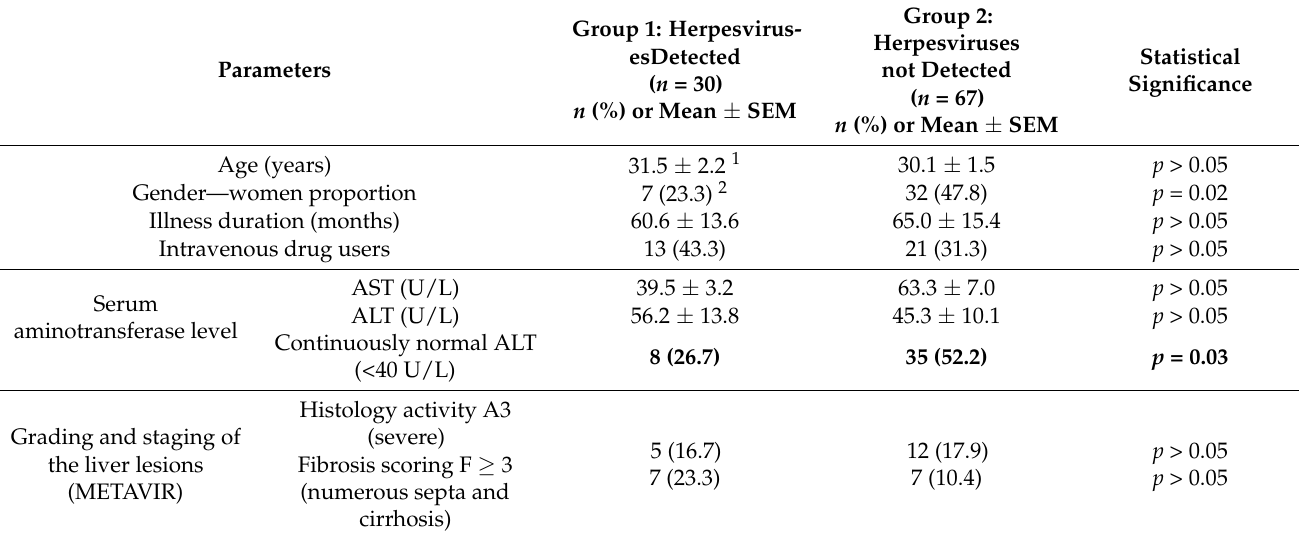
Table 3. Comparison of the demographic, histological, and serologic characteristics of patients with chronic hepatitis C depending on the detection of herpesvirus DNA in liver and blood